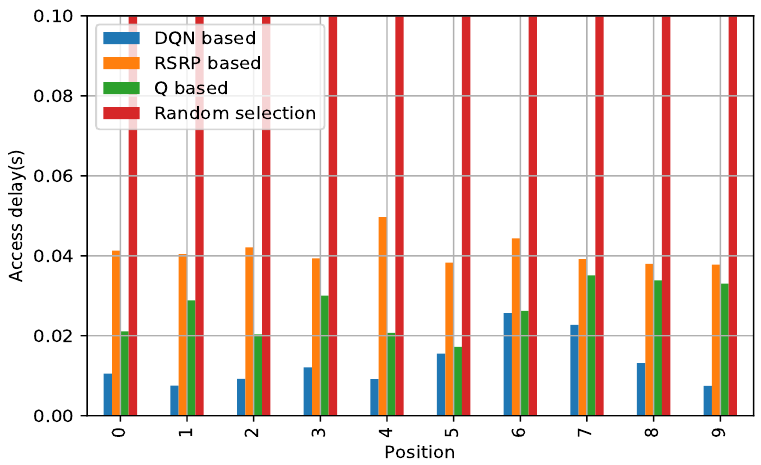
Figure 7. Comparison of access delay: DQN based vs. others in random access network environment.